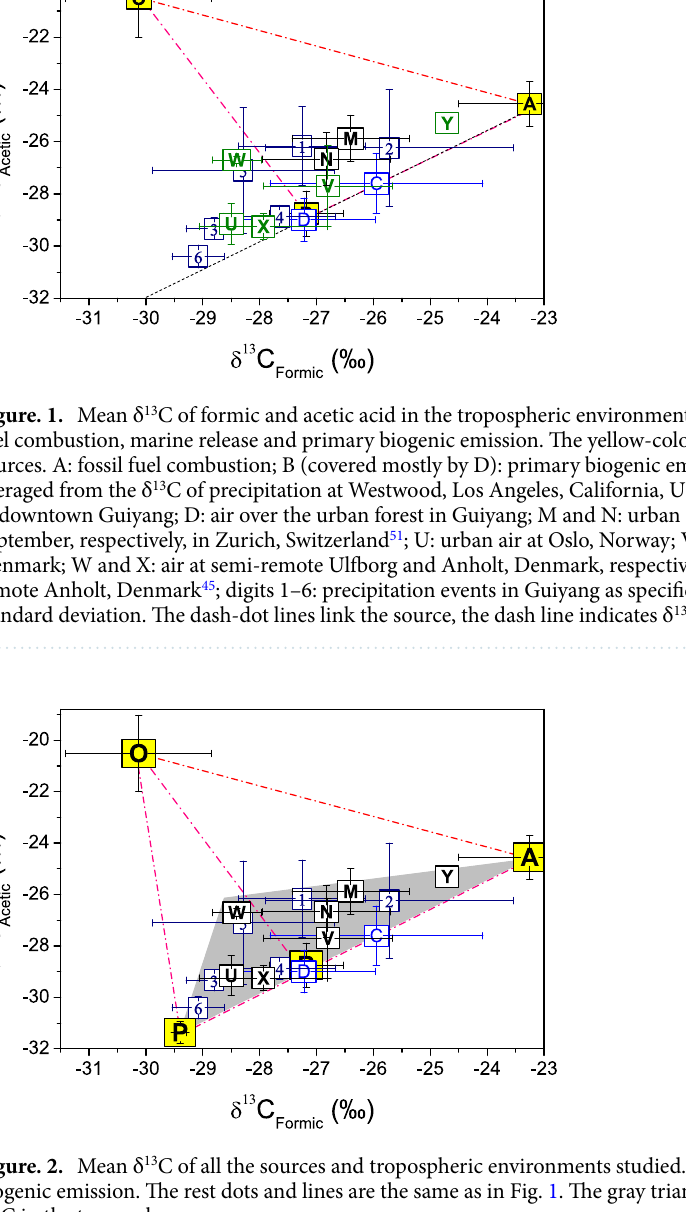
among all the tropospheric environments in question thanks to its geographic and atmospheric situations. The air in Zurich, Switzerland, was affected by stronger photo-oxidation in August–September than in March 51 , the former is closer to the source of secondary biogenic emission than the latter in the isotope compositions, corroborating that the air of summer season has higher acids of secondary biogenic origin. These consistencies indicate that the isotopic compositions of the double acids point to their origins very well in the troposphere. The δ 13 C of troposphere varies substantially between samplings even at the same site as indicated by the large standard deviation of the means. This is consistent with the volatile nature of atmosphere. Nevertheless, all the data are concentrated in an area that fits well a triangle as grayed in the isotopic system (Fig. 2). The distribu- tion is away from the marine source while inclining toward the secondary biogenic emission. It indicates that the oceanic contribution is the least, especially in terms of acetic acid, while the secondary biogenic one most important to the tropospheric acids. This is in agreement with recent model studies 31,35,52 and also confirmed by the model of Stable Isotope Analysis in R (SIAR) (Table S2), which predicts contribution of each source to the mixture based on probability distribution 53 . It shows that, on average, the marine origin accounts for 16% while the secondary biogenic emission 34% of acetic acid in the troposphere. The vehicle exhaust contributes 21% following the marine release as the second least source. The primary biogenic emission is located near the